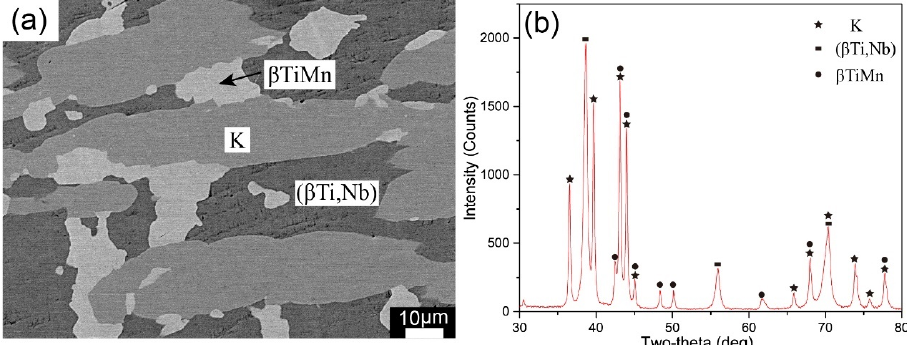
Figure 14. Alloy B6 annealed at 1273K for 60 days: ( a ) BSE images, ( b ) XRD patterns.